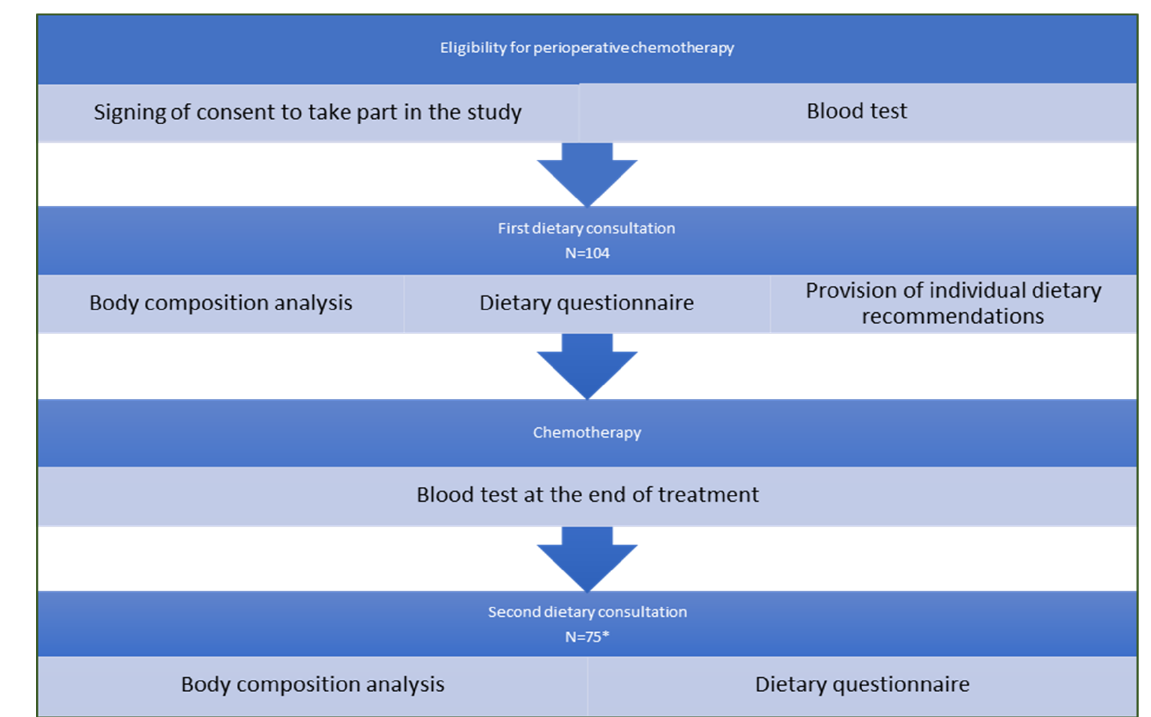
Figure 1. Flow chart—schematic of the study. * All participants in the study survived and completed chemotherapy, and the proportion of patients who did not return after treatment was due to reasons beyond the study design. We suspect that in some participants, the reasons were ill health and distance of residence from the treatment centre.